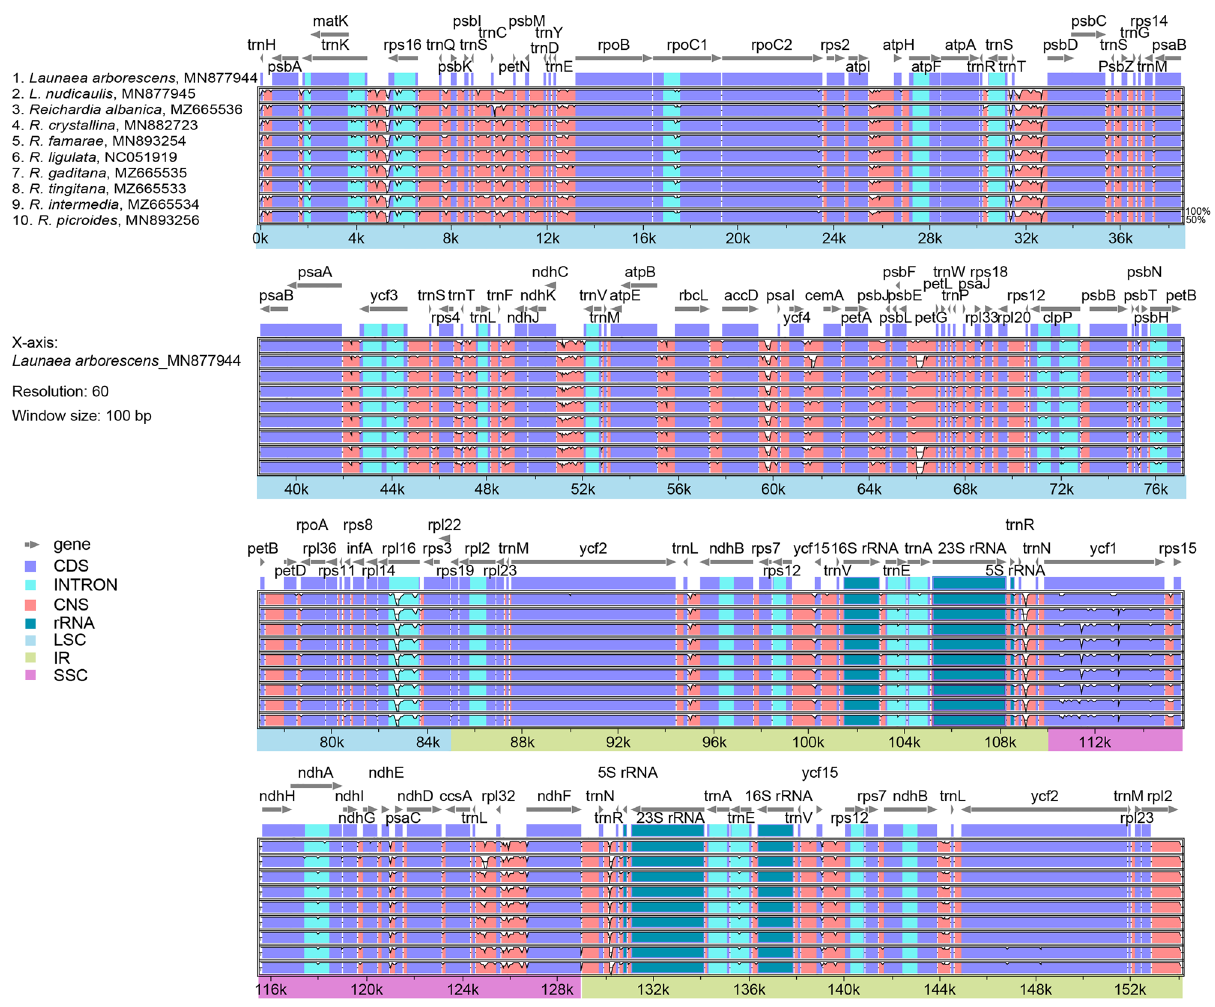
Figure 5. Comparison of the chloroplast genomes of eight Reichardia and two Launaea species against L. arborescens using mVISTA. Grey arrows indicate genes with their orientation and position. Genome regions are color-coded, as